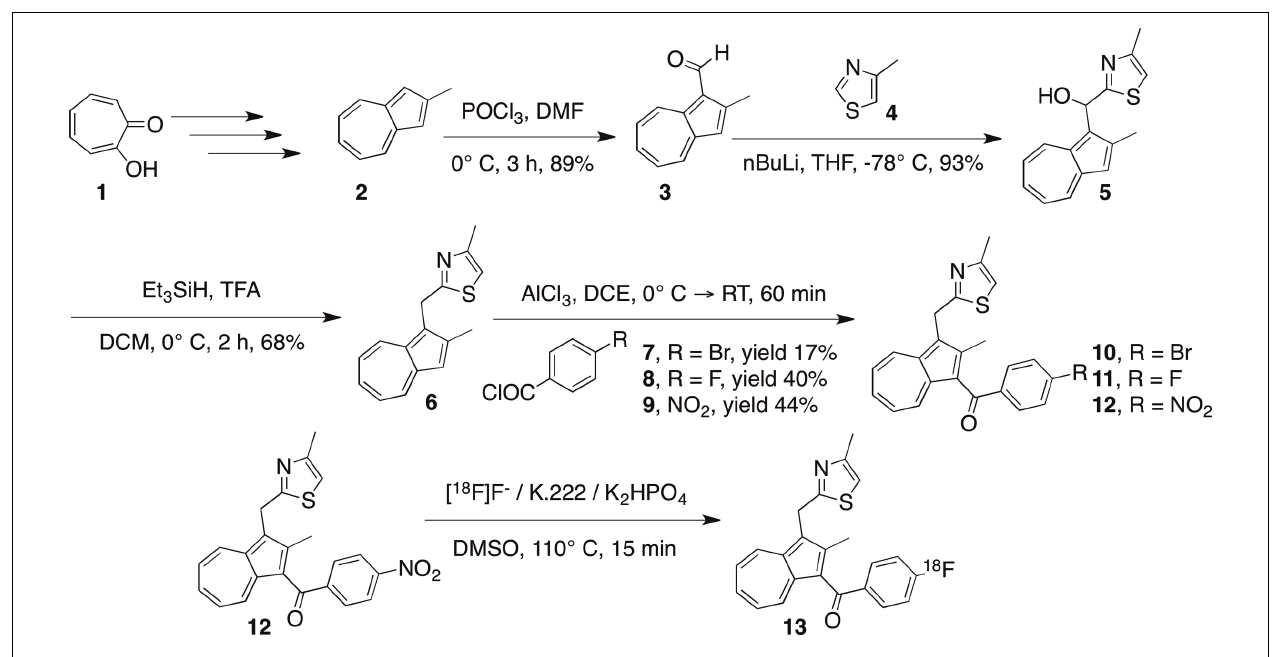
FIGURE 1 |The design of a convergent synthesis approach to develop an azulene-based 18 F-COX2 probe 13 and its related precursors.